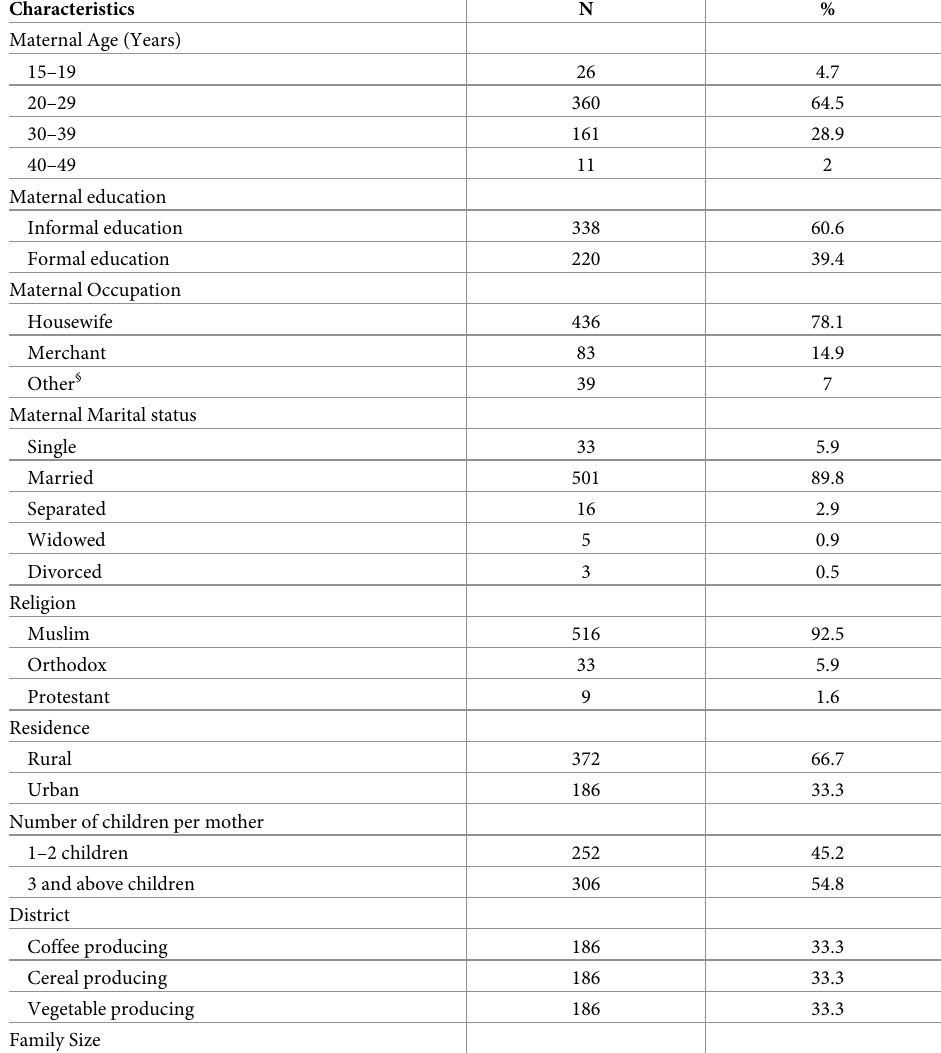
Table 1. Maternal and household characteristics (Jimma Zone, Southwest Ethiopia